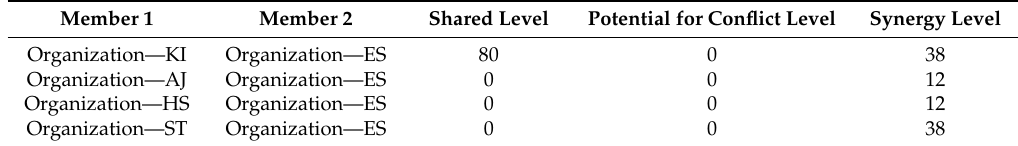
Table 7. Detailed results for the integration of a new member in a VO Consortium